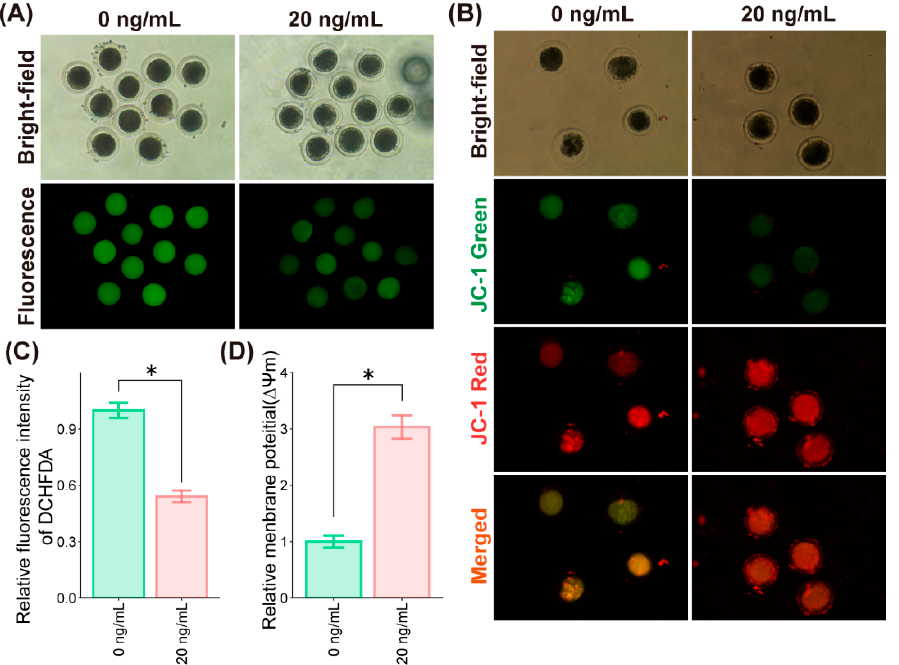
Figure 3. SDF1 supplementation alleviates oxidative stress in the porcine oocytes during IVM. ( A ) Representative images of the control and SDF1-treated oocytes incubated with H 2 DCFDA showing ROS production. ( B ) Representative images of the control and SDF1-treated oocytes incubated with JC-1 for ∆Ψ m measurements. ( C ) ROS levels in the indicated groups were calculated in terms of the intensity of green fluorescence. ( D ) ∆Ψ m in the indicated groups was calculated as the ratio of red/green fluorescence intensity. Values are presented as mean ± SD. “*” represents p < 0.05.